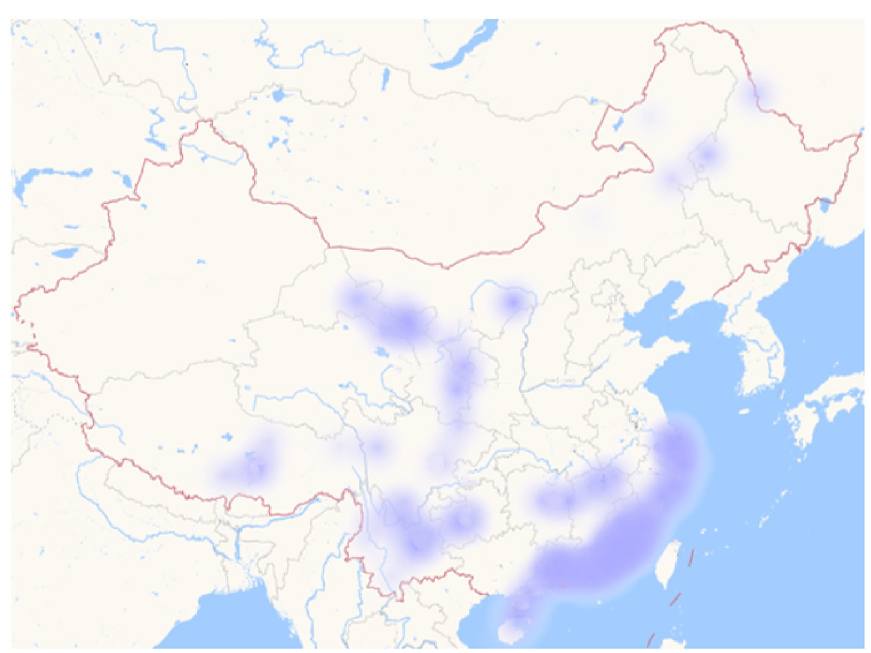
Fig 9. The process of a realistic case [25]. Republished from [https://unsplash.com/s/photos/china-map] under a CC BY license, with permission from [Unsplash], original copyright [original copyright 2020].